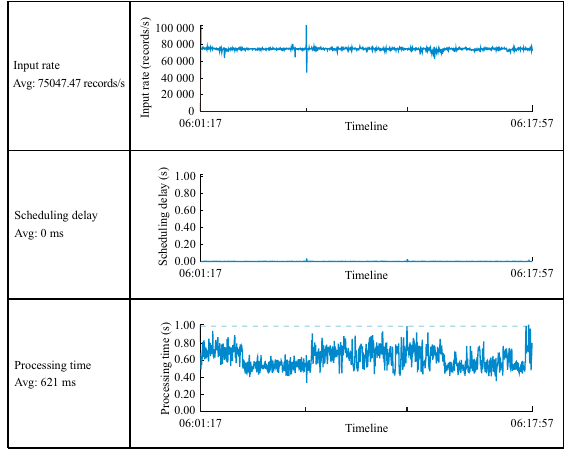
Fig. 5 Performance statistics of stream processor in Spark UI, where processing time is the time taken to process all jobs for a batch, and scheduling delay is the time to ship the jobs from scheduler to executor.